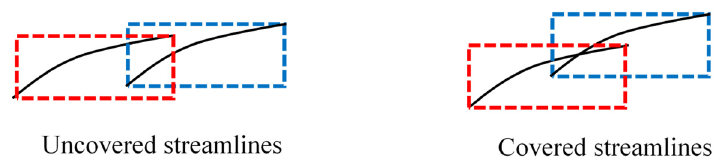
Figure 3. Schematic diagram of two kinds of streamline encased rectangular covering situation. The left image represents a case where the streamlines do not conflict, and it should not be excluded. The right-hand image is one that represents conflict, and it should be excluded.